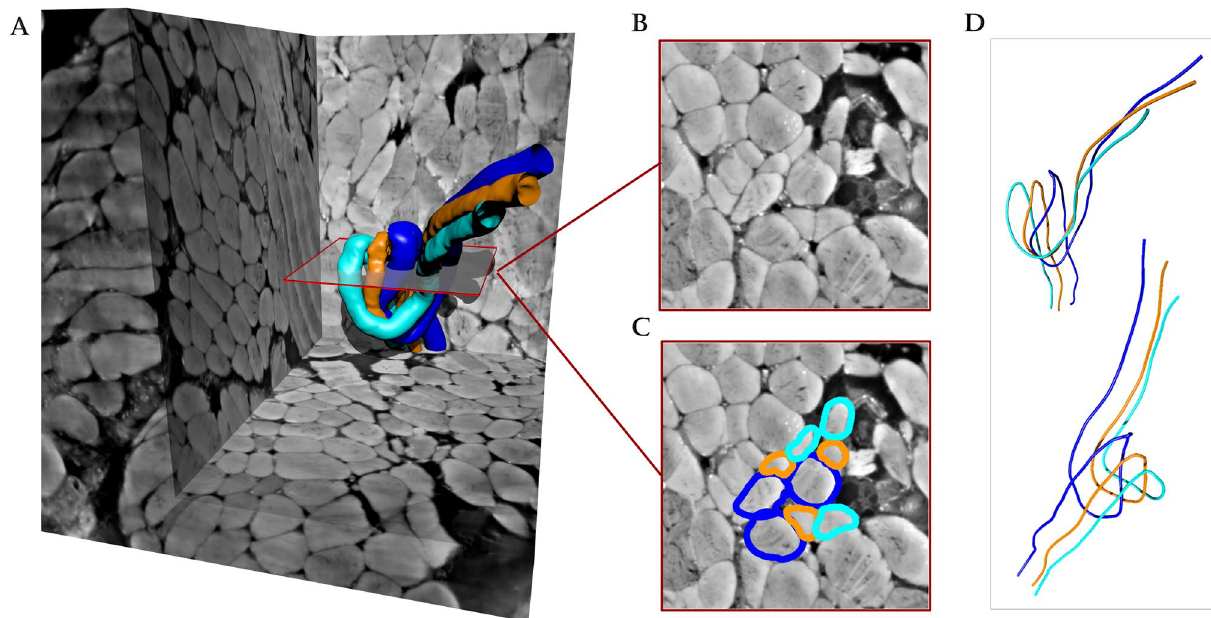
Figure 7. Buckling fiber visualization. ( A ) Rendering of segmented muscle fibers. ( B ) A small cut-out plane of the marked region. ( C ) Same region as B with borders of the segmentation overlaid. ( D ) Visualization of the muscle fiber centerlines from two different viewpoints. The figure was created using MatLab software (v2020b): https:// www. mathw orks. com/ produ cts/ new_ produ cts/ relea se202 0b. html and Blender software (v2.78c): https:// www. blend er. org/ downl oad/ relea ses/2-